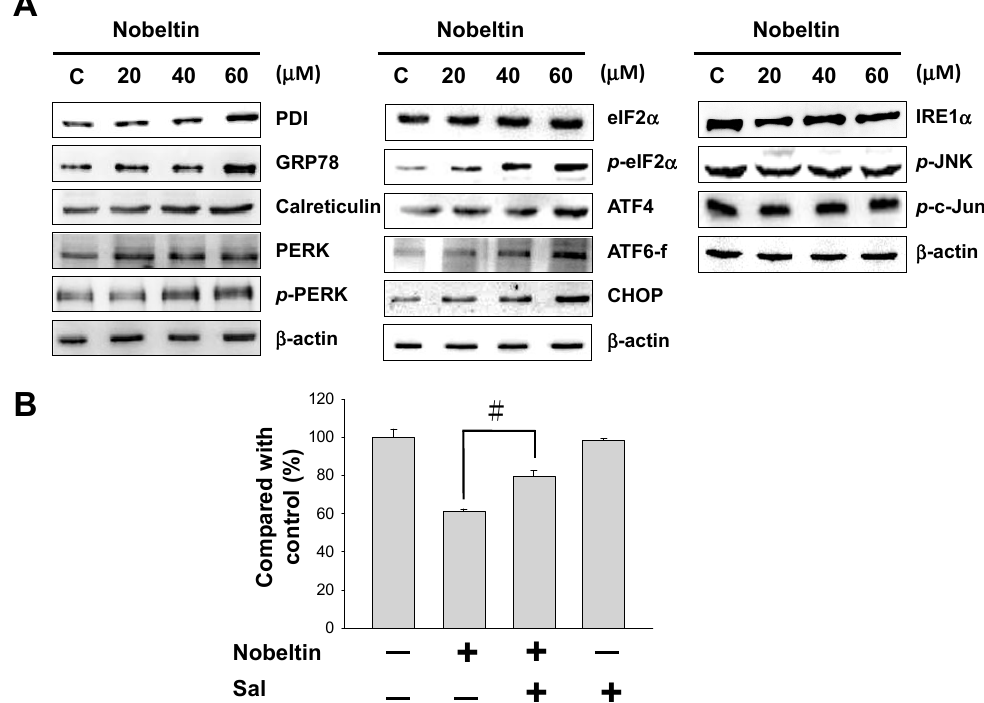
Figure 4. Western blot analysis of ER stress-related proteins in NOB-treated BFTC bladder cancer cells. ( A ) BFTC cells were treated with di ff erent concentrations of NOB (20–60 µ M) for 24 h. The protein lysates were subjected to western blot analysis with antibodies against PDI, GRP78, calreticulin, PERK, p -PERK, eIF2 α , p -eIF2 α , IRE-1 α , p -JNK, p -c-Jun, ATF4, ATF6-f, and CHOP proteins. An antibody